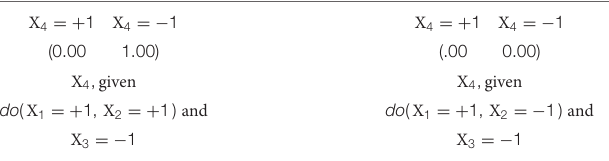
TABLE 5 | Probabilistic distributions corresponding to observation of X 4 under causal